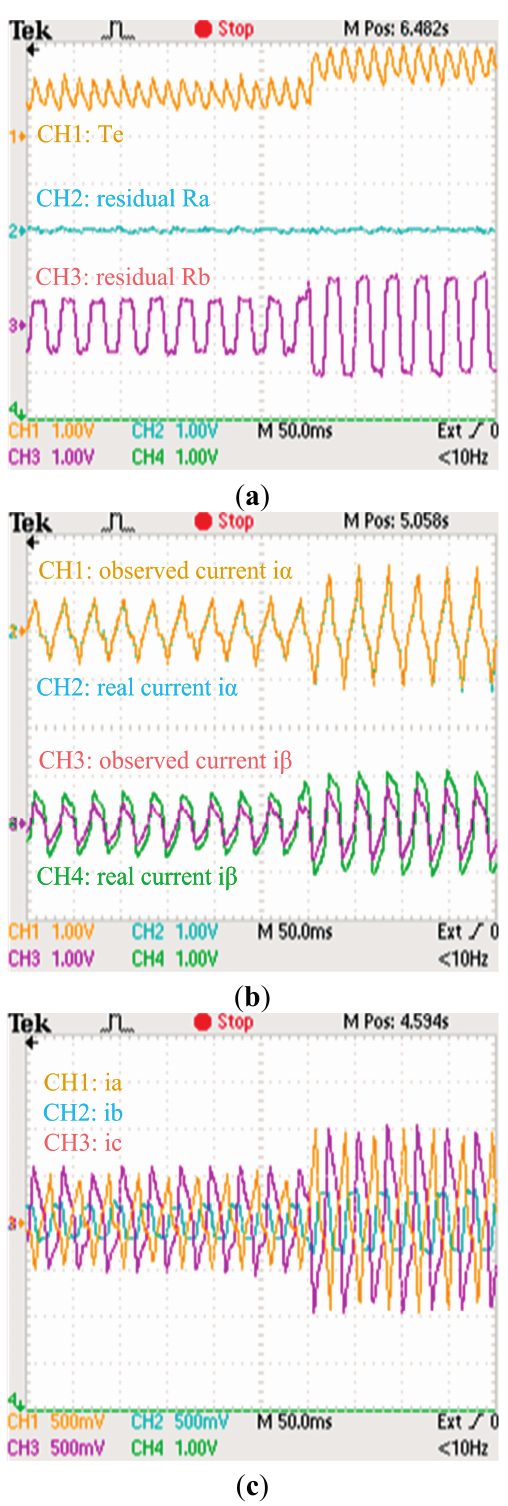
Figure 26. Experimental results when a gain fault is applied to the phase ‘b’ current sensor: ( a ) Zoom of experimental electromagnetic torque and residual responses; ( b ) Zoom of experimental actual and observing stator currents responses; ( c ) Zoom of experimental phase currents responses. (a) (torque: 500 Nm/div; residual: 60 A/div; t: 50 ms/div); (b) (current: 150 A/div; t: 50 ms/div); (c) (current: 100 A/div; t: 50